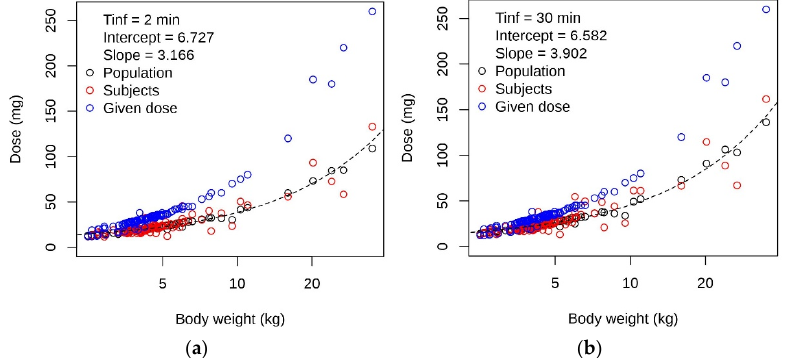
Figure 5. Predicted doses to reach C (30 min’) between 10 and 12 mg/L, calculated with the final model and compared to the given doses. ( a ) For 2 min and ( b ) for 30 min infusion duration. Predictions were made on the population (black symbols) and individual (red symbols) level. Blue symbols, given dose. Broken line, line with intercept (in mg) and slope (in mg/kg) from the linear regression analysis (predicted dose on individual level vs. body weight, parameters as indicated in the plots; note that bodyweight is in logarithmic scale).